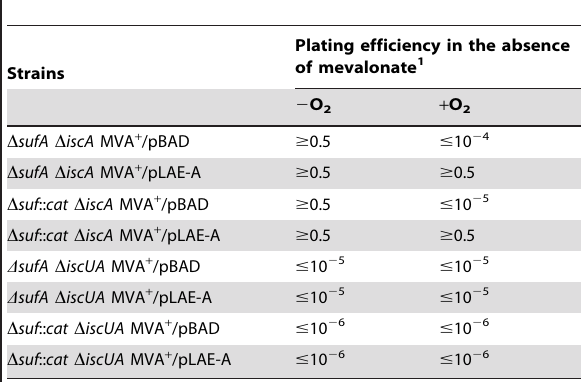
Table 6. Increased erpA gene dosage suppresses the sufA iscA double mutant phenotype via IscU